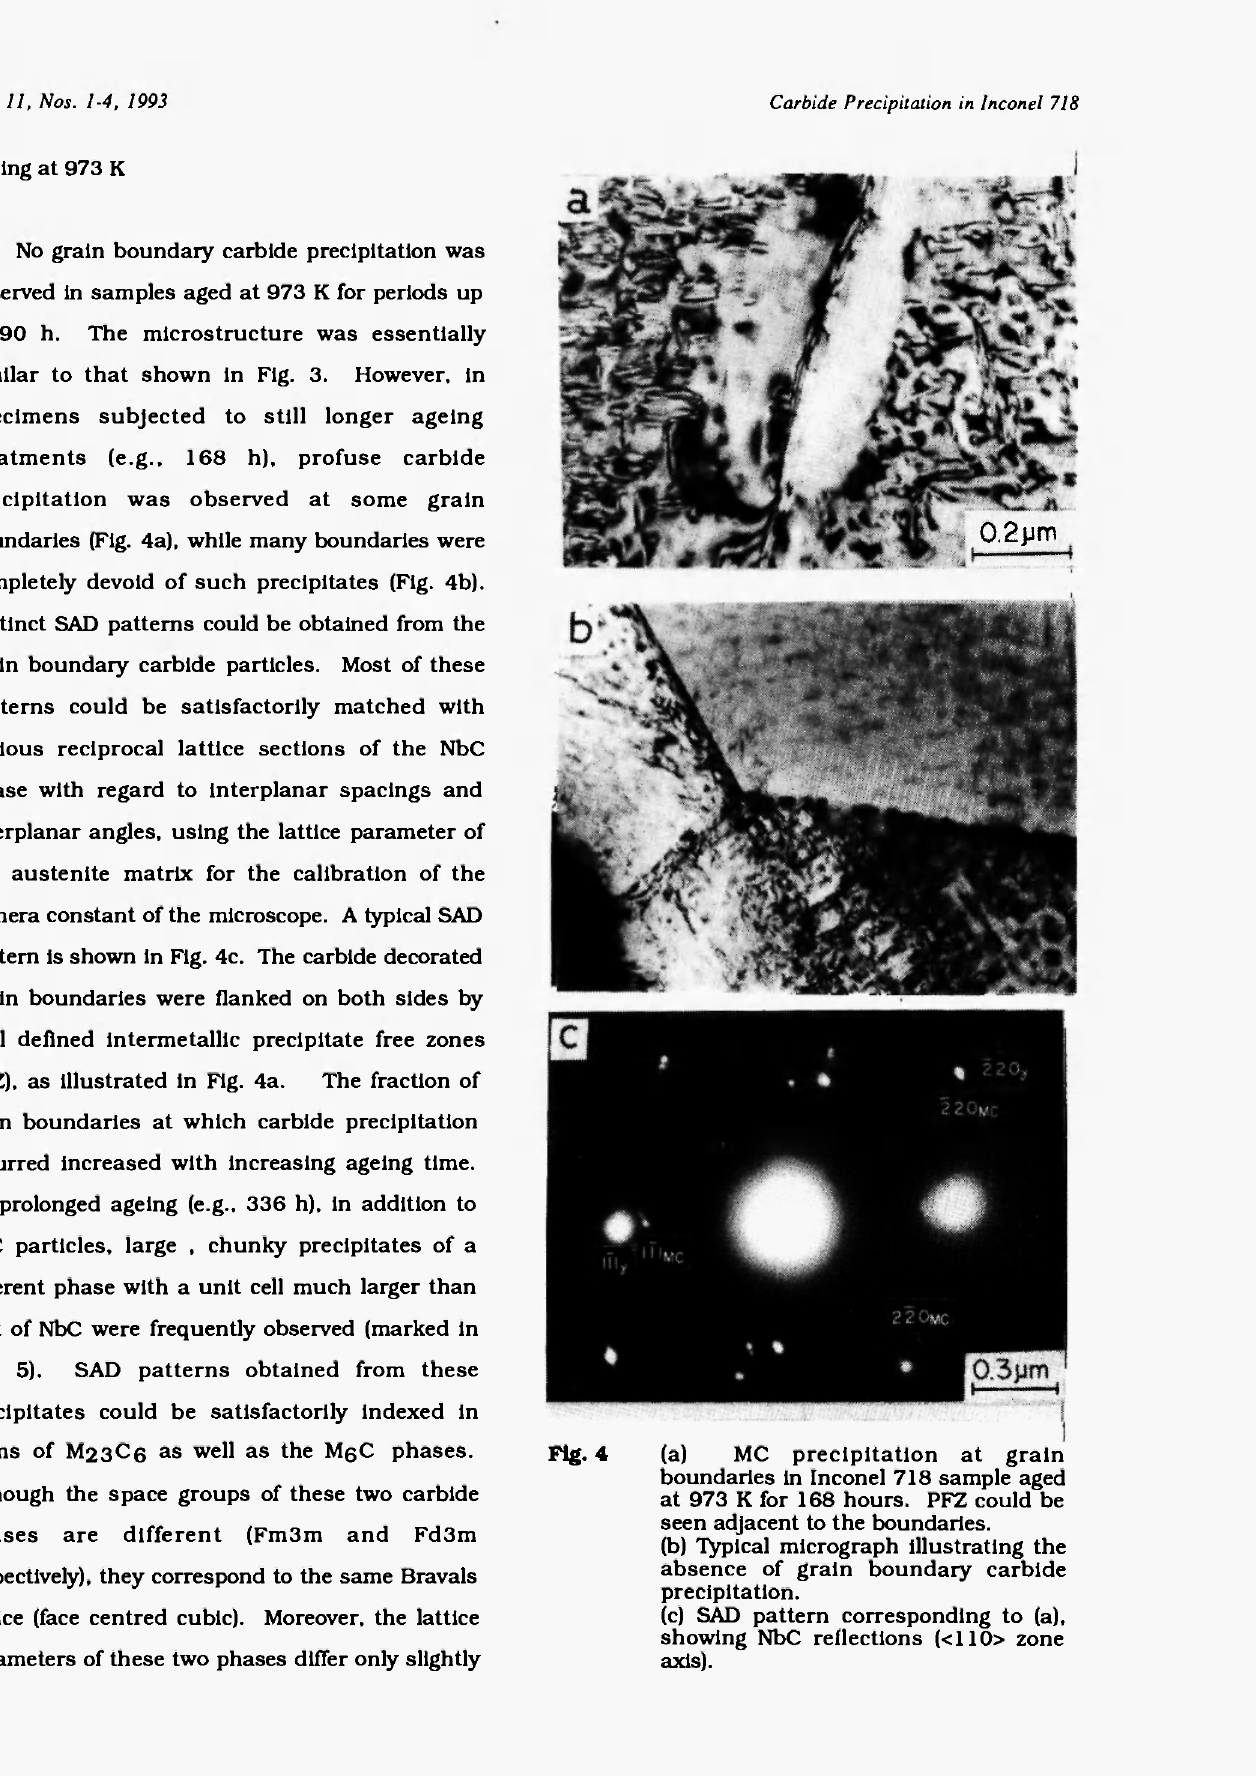
Fig. 4 (a) MC precipitation at grain boundaries in Inconel 718 sample aged at 973 Κ for 168 hours. PFZ could be seen adjacent to the boundaries. (b) Typical micrograph Illustrating the absence of grain boundary carbide precipitation. (c) SAD pattern corresponding to (a), showing NbC reflections (<110> zone